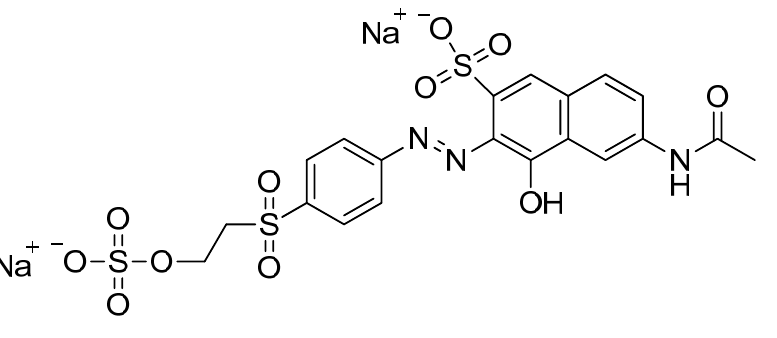
Figure 1. Structure of RO 16.